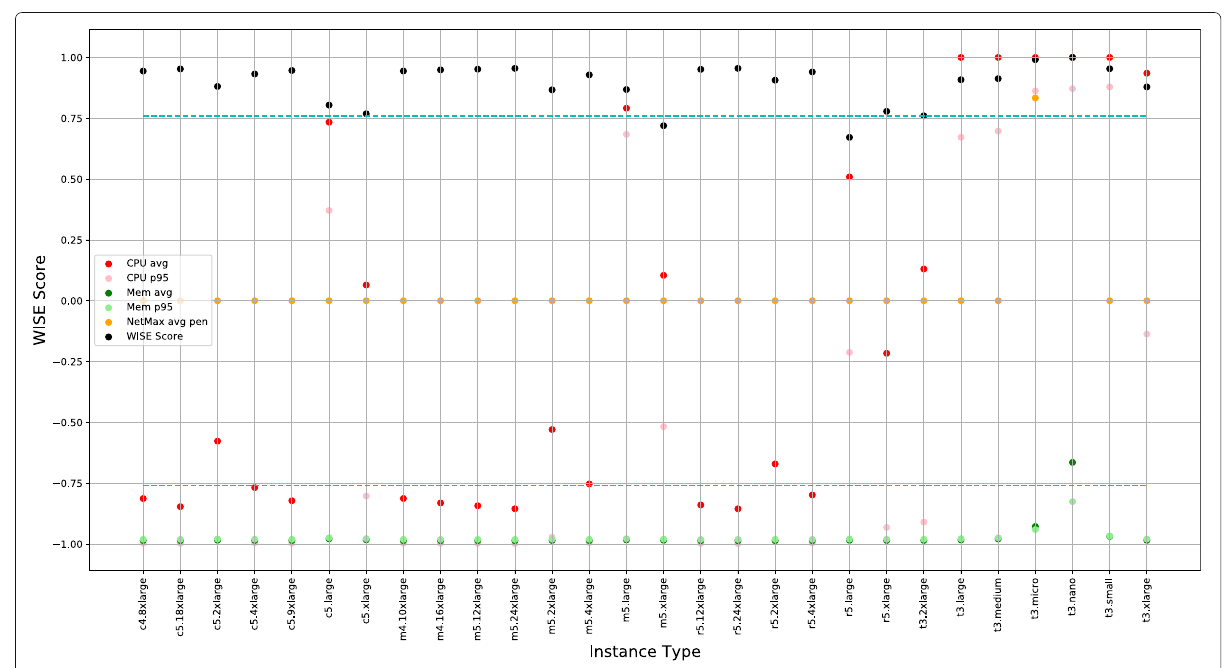
Fig. 4 WISE scores using the hyperbolic tangent function and (cid:4) 1 -norm for MongoDB Workload